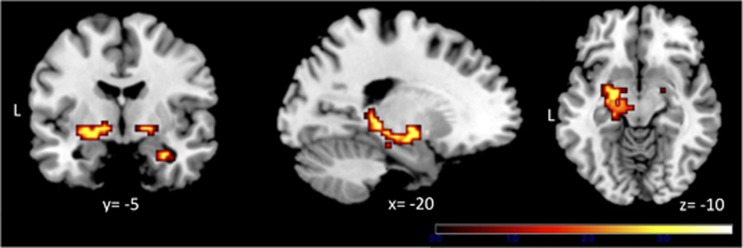
Ultra high-risk (UHR) subjects showed greater activation than healthy controls (HCs) in relation to reward-predicting stimuli in the ventral pallidum bilaterally and in the left midbrain/hippocampus. Images are displayed at a cluster-forming threshold of P<0.005.